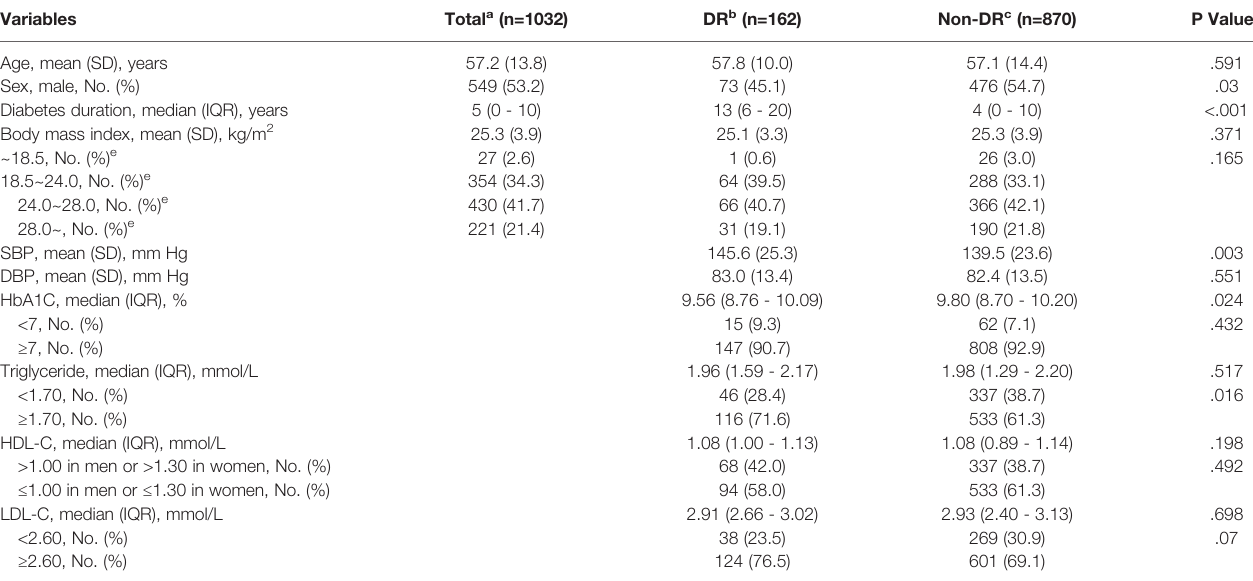
TABLE 1 | Characteristics of patients with T2DM according to DR